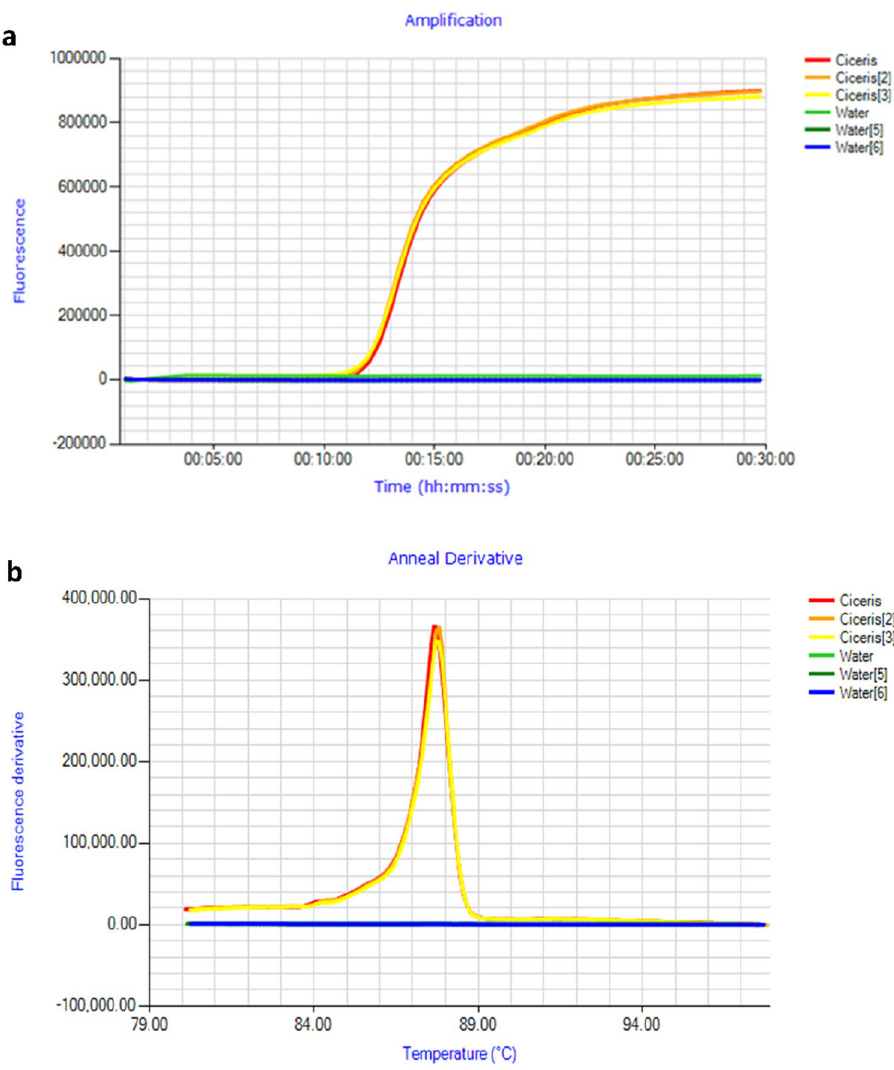
Figure 2. Optimised LAMP assay performed on genomic Fusarium oxysporum f. sp. c iceris DNA ( a ) Amplification profile, with positive samples amplifying in < 13 min. ( b ) Anneal derivative of LAMP amplicons, with an average anneal derivative of 87.7 °C.